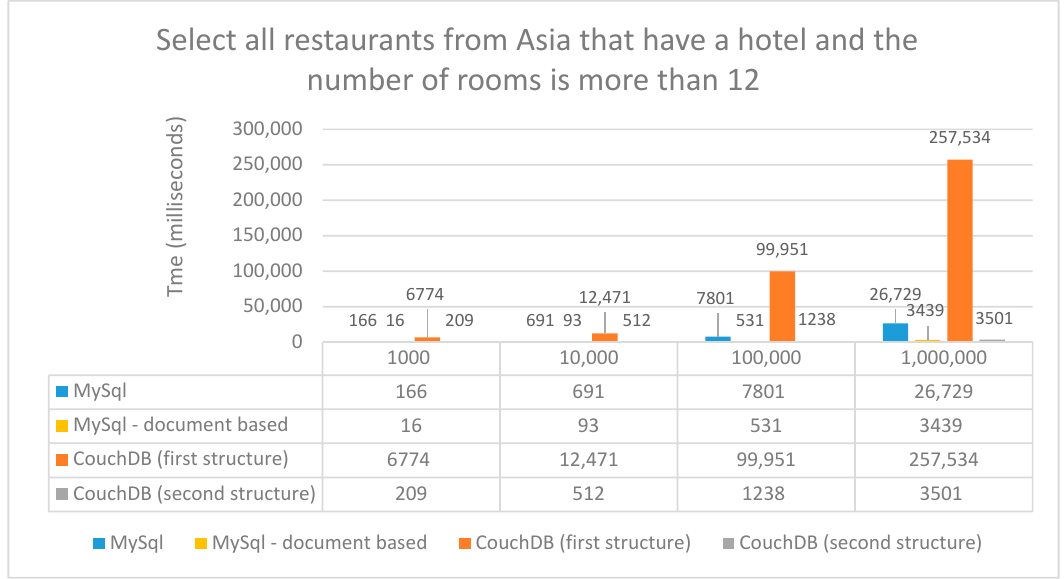
Figure 11. Performance time (ms) for select with four inner joins.